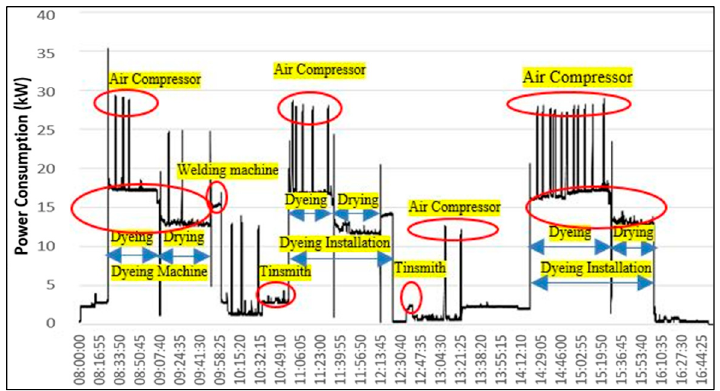
Figure 13. The consumption sampled at 5 s in a day with high intensity of the activity.